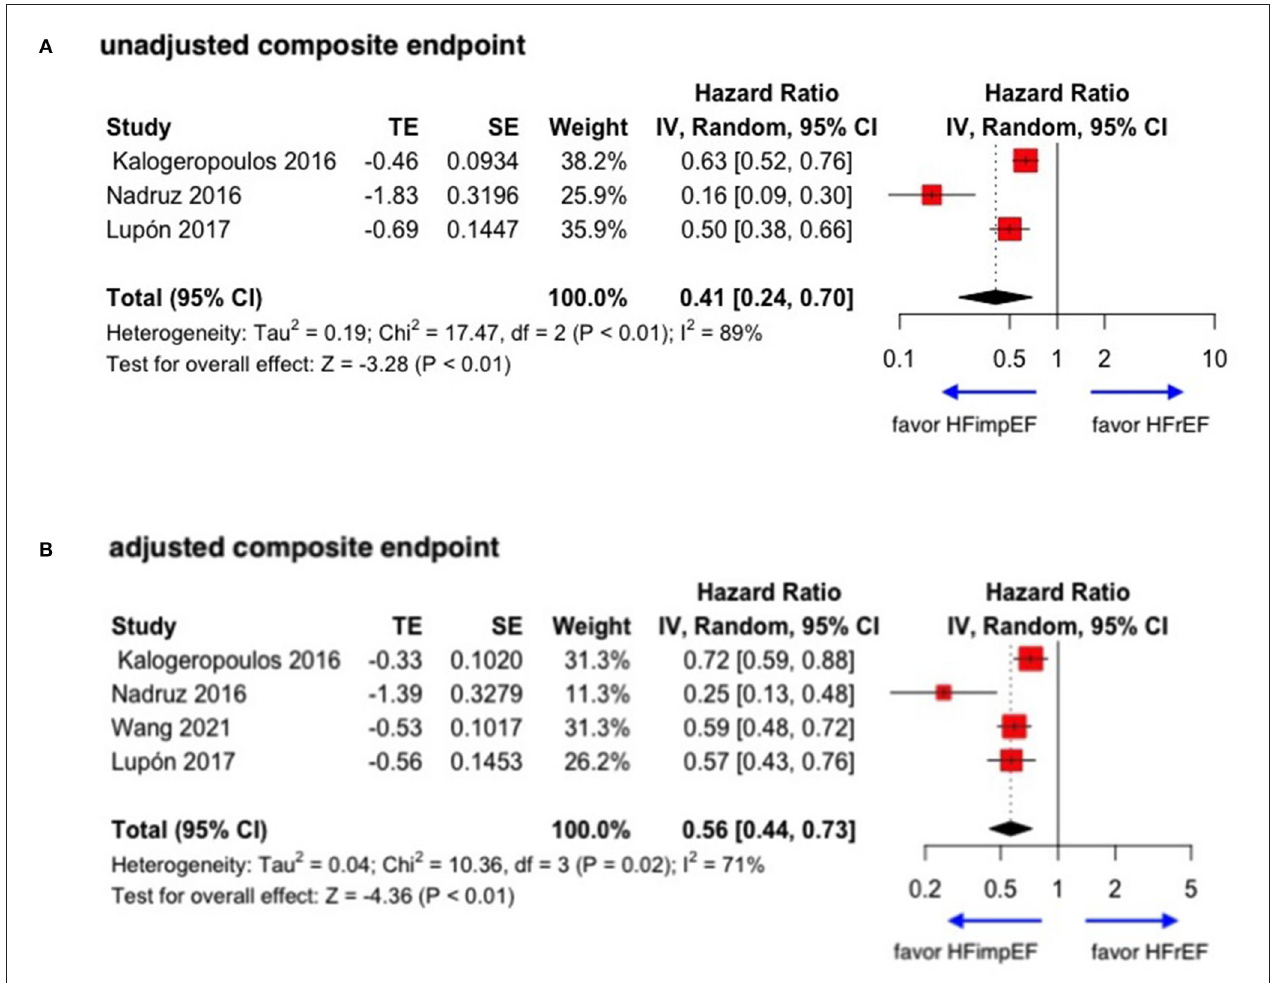
FIGURE 5 | Forest plots of unadjusted and adjusted composite endpoint in patients between HFimpEF and HFrEF. (A) Unadjusted composite endpoint. (B) Adjusted composite endpoint.